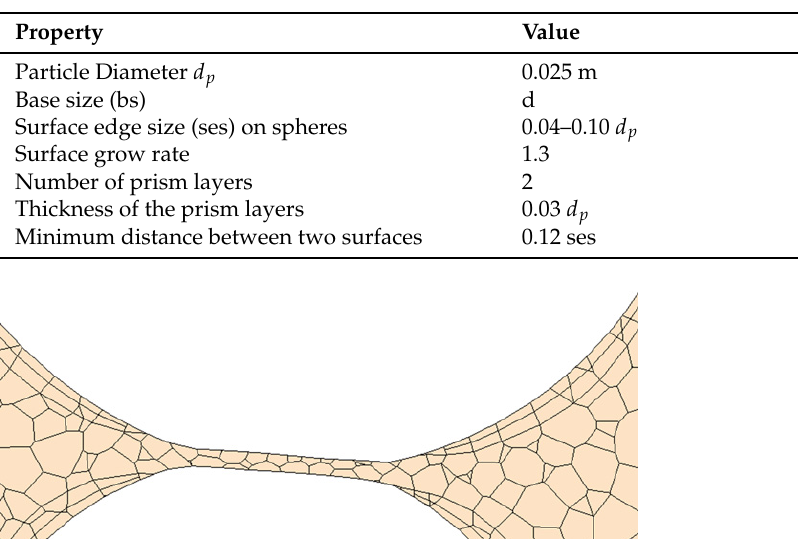
Table 2. Settings of the meshing parameters.